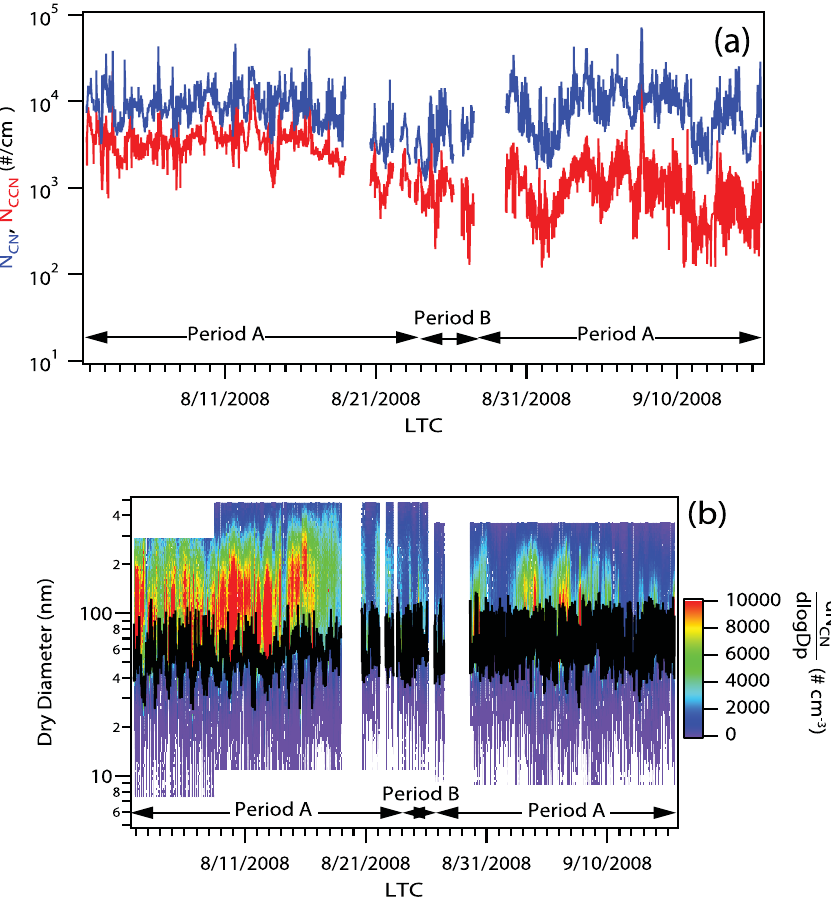
Fig. 2. (a) Total CN and CCN time-series (for all five supersaturations studied during the AMIGAS campaign) for whole AMIGAS campaign. (b) Particle size distribution time-series with characteristic dry diameter, d p , c (black line). Period A corresponds to “polluted” air masses originating from the continental US; period B corresponds to “cleaner” air masses originating from either the Atlantic Ocean or Gulf of Mexico. Gaps in data are a result of instrument